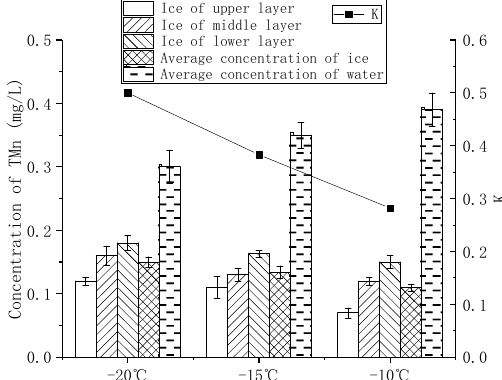
Figure 5. Distribution of TMn at Varying Freezing Temperatures in the Ice-water System.